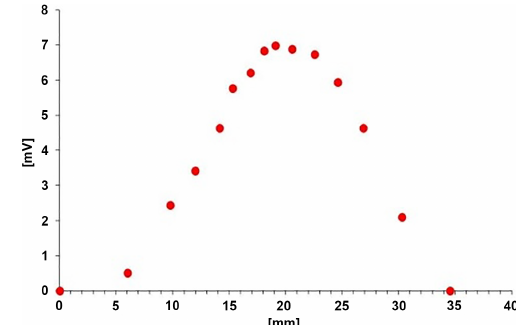
Figure 6. Back-reflected light intensity against fibre head or target distance.